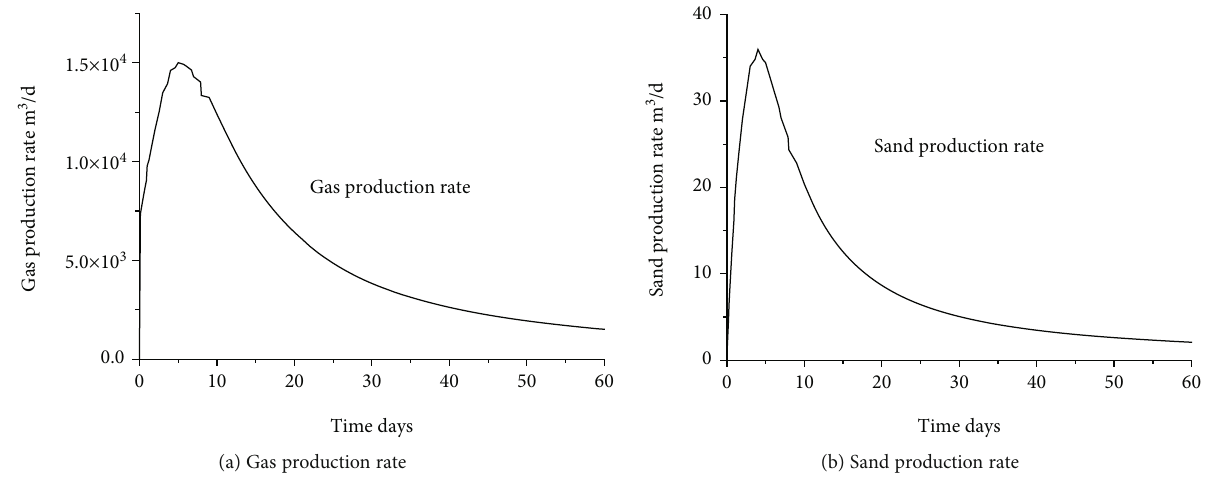
Figure 3: Simulation results of gas production rate and sand production rate.